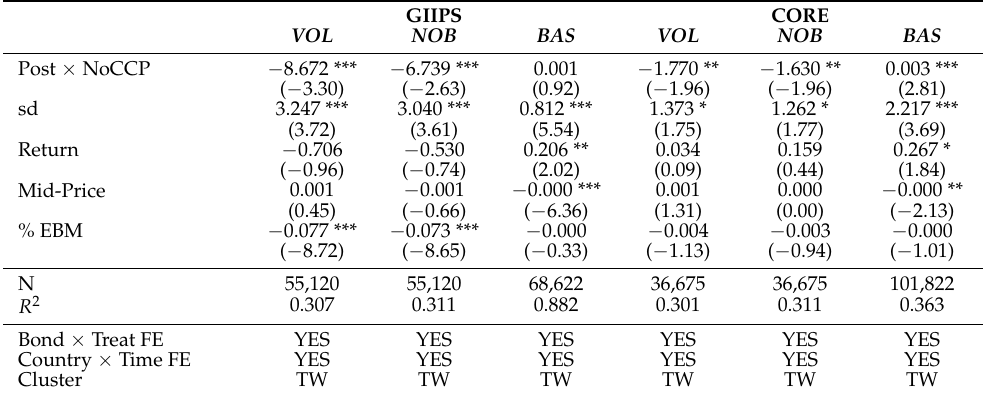
Table 12. Country group